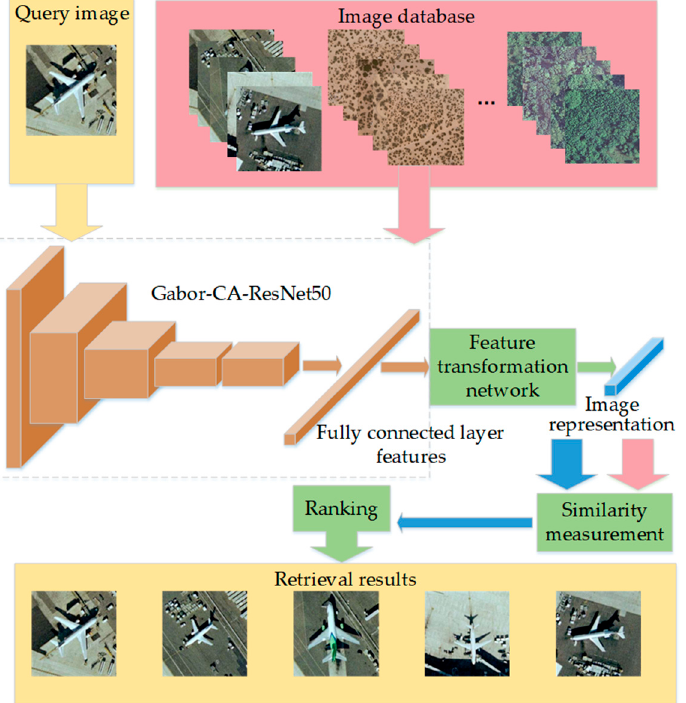
Figure 1. The remote sensing image retrieval framework of Gabor-CA-ResNet and split-based deep feature transform network.